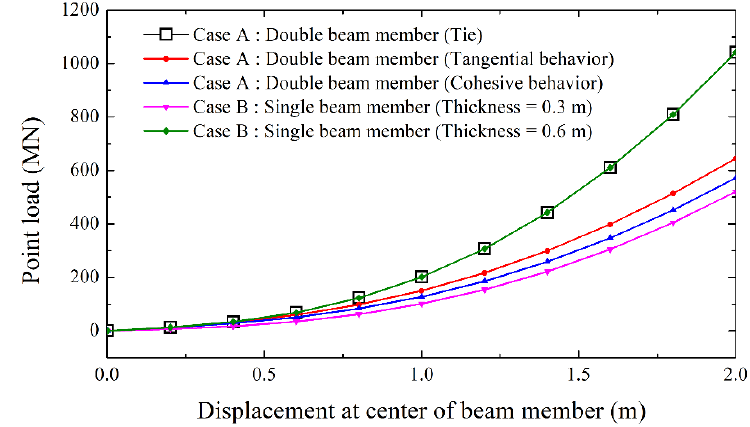
Figure 11. Analysis of contact behavior of general beam members.